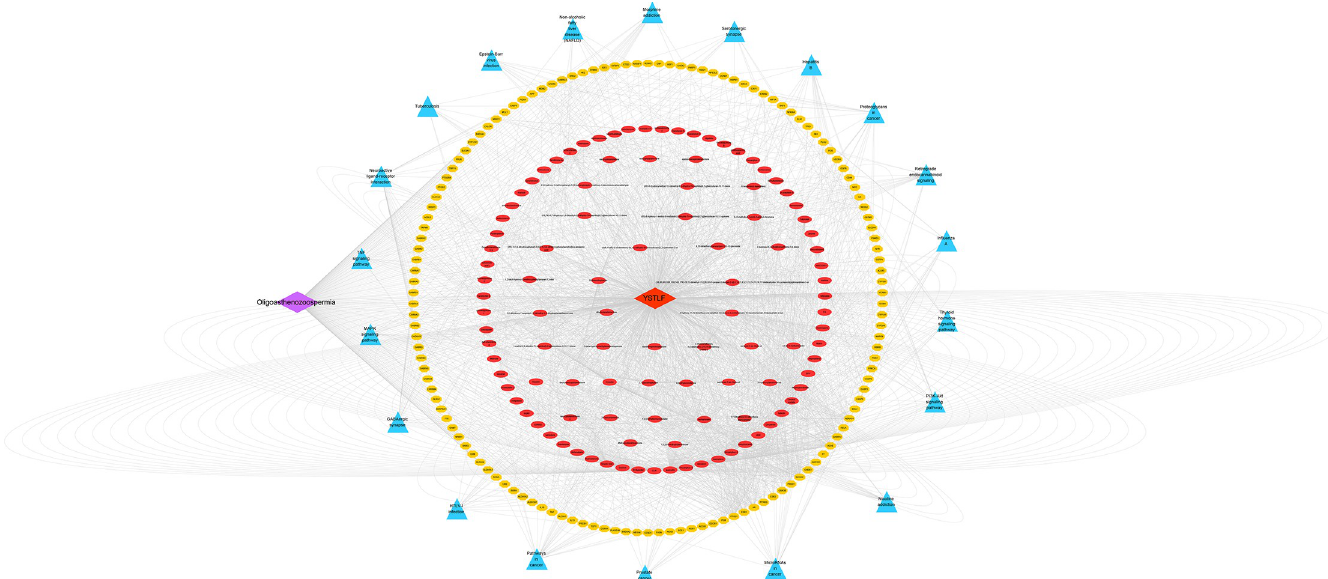
Fig 7. Disease-formula-compound-target-pathway network. Purple rhombuses represent disease, red rhombuses represent formulae, red ellipses represent the chemical compounds in YSTLF related to the common targets, yellow polygons represent the common targets from the chemical compounds and oligoasthenozoospermia, and blue triangles represent the main biological